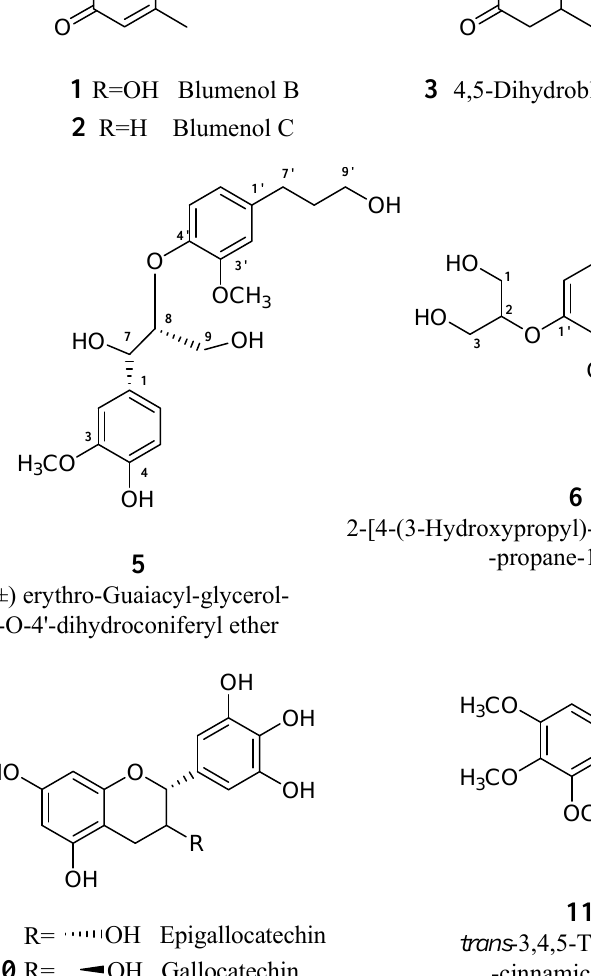
1 R=OH Blumenol B 3 4,5-Dihydroblumenol A 4 3’,4- O